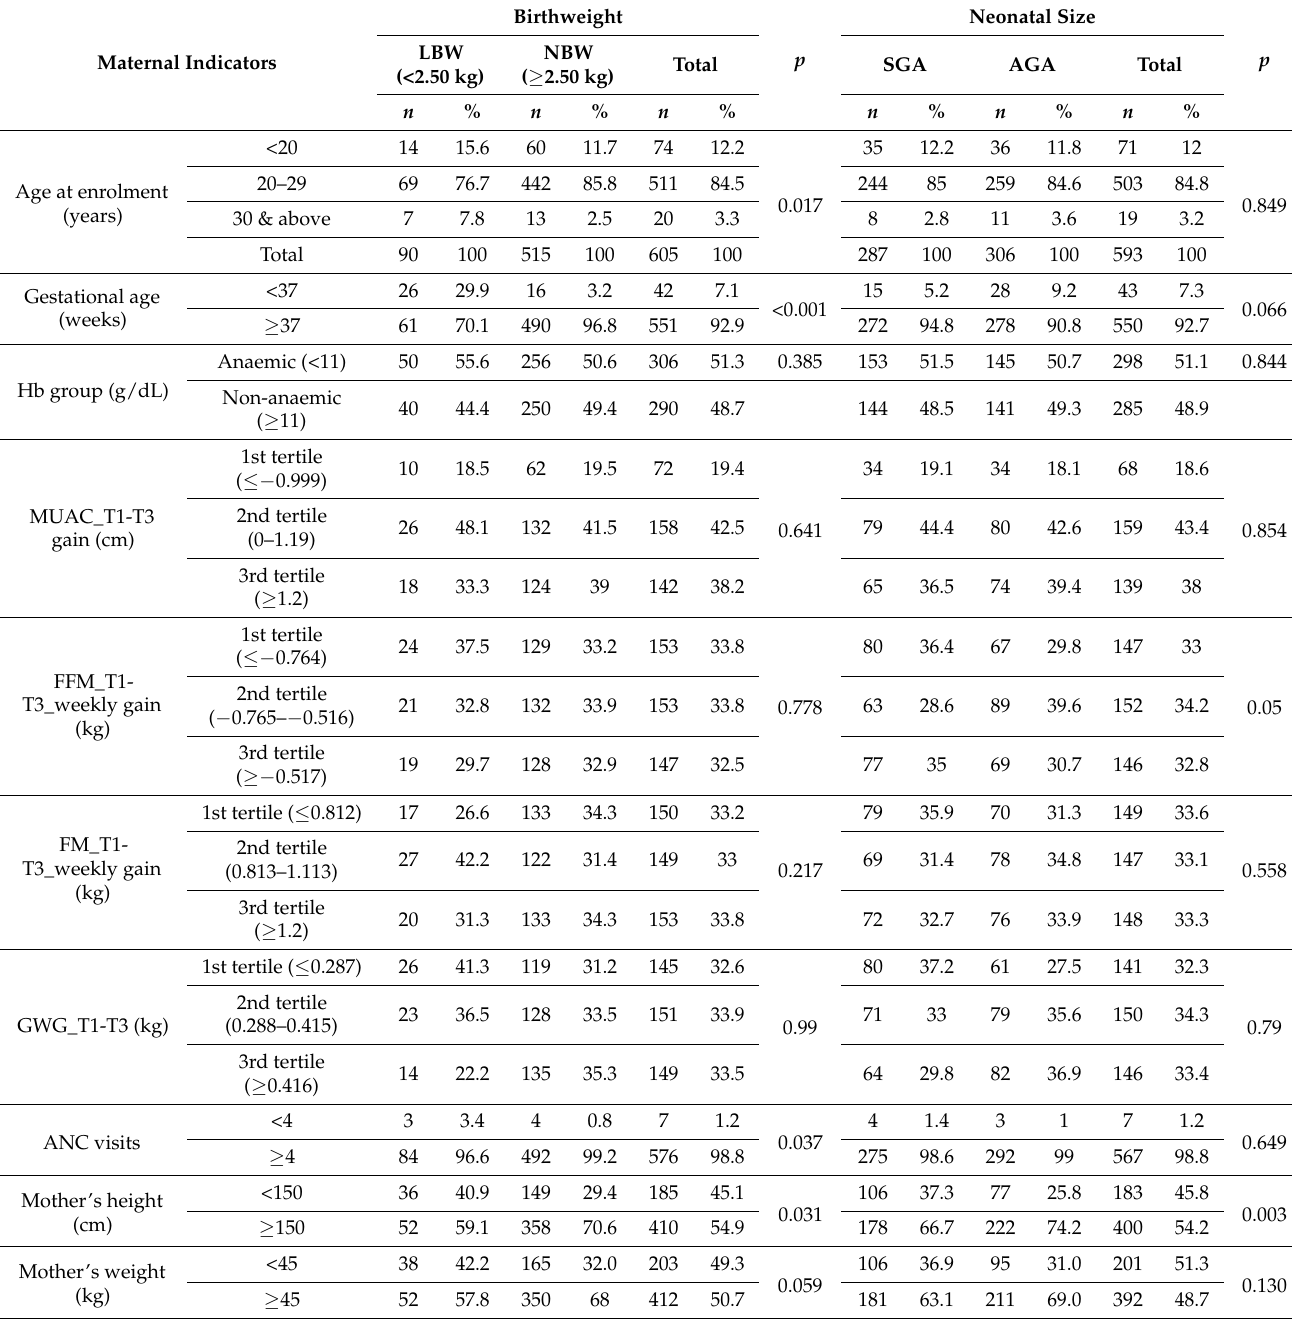
Table 4. Infant birthweight based on maternal anthropometry, gestational weight gain and body